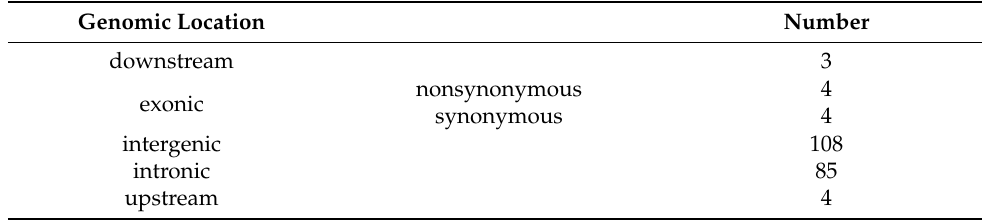
Table 2. The genomic distributions of the BSA-SNPs shared by three strains. Genomic Location Number downstream 3 nonsynonymous exonic